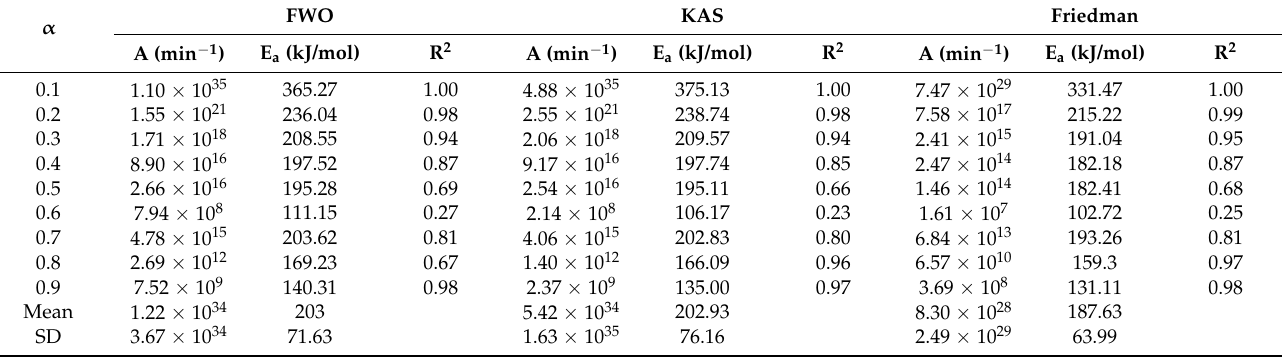
Table 4. Kinetic parameters of RDF fraction by Flynn–Wall–Ozawa (FWO), Kissinger–Akahira–Sunose (KAS), and Friedman